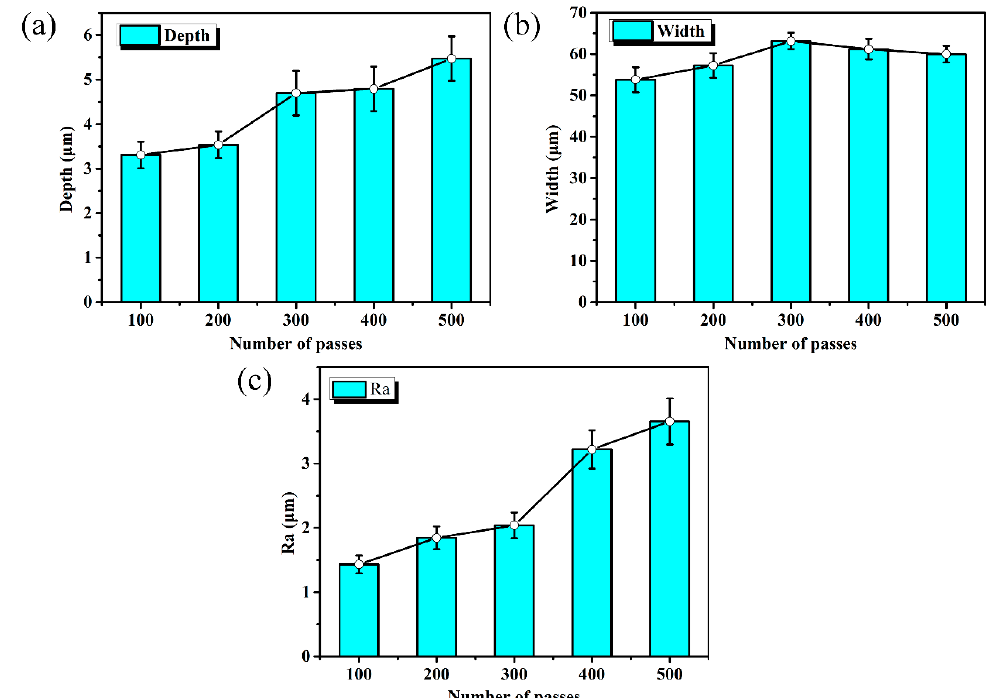
Figure 9. The width, depth, and Ra of microdimple structures under different numbers of passes. ( a ) The influence of number of passes on dimple depth. ( b ) The influence of number of passes on dimple width. ( c ) The influence of number of passes on surface roughness Ra .